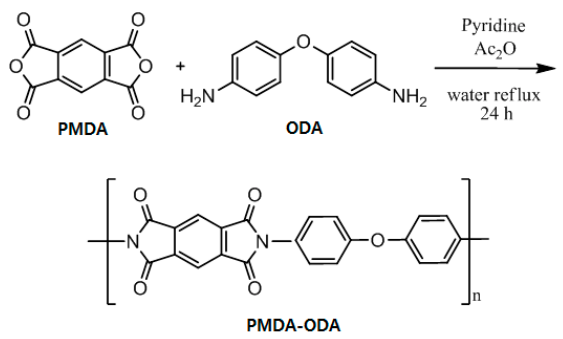
Scheme 1. Synthesis of PMDA-ODA oligoimide in water.